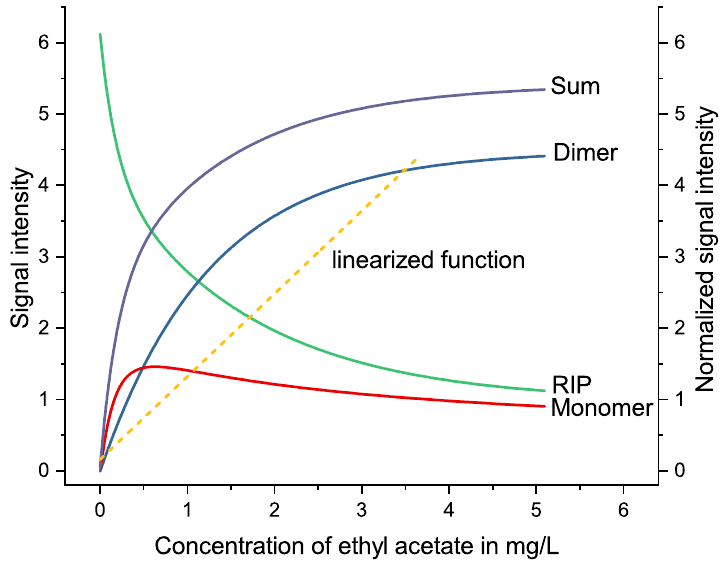
Figure 1. Fitted plot showing the analyte signal intensities for monomer and dimer, as well as the RIP for an increasing concentration of ethyl acetate in a sample in relation to the linearized